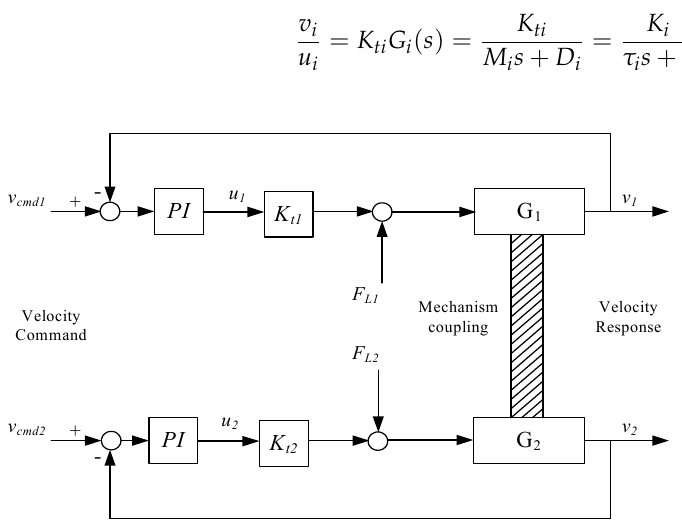
Figure 3. The PI controller loop for parameter identification.